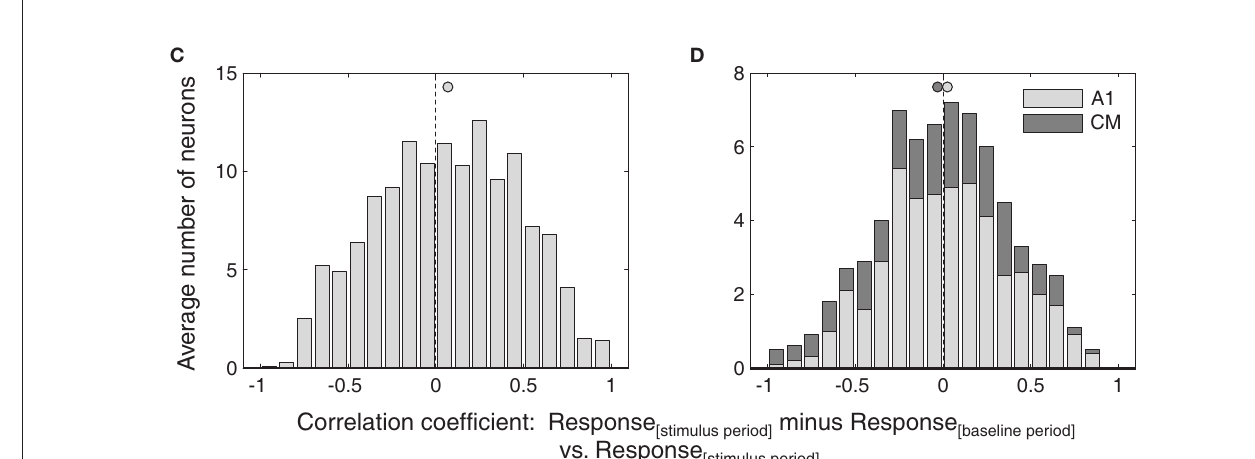
neurons in the data set regardless of whether they were demonstrably sensitive to eye position according to the ANOVA. Activity was pooled across sound location. Filled circles indicate the mean.